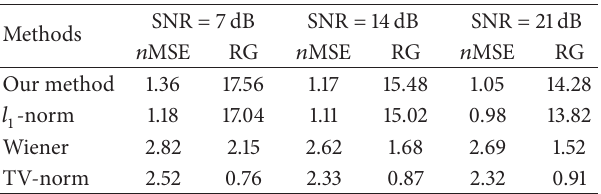
Table 1: Comparison of different restoration techniques according to 𝑛 MSE ( 𝑛 -Mean Square Error) from (10) and RG (resolution gain). RG is a parameter which evaluates the level of decorrelation for speckle noise in the resulted